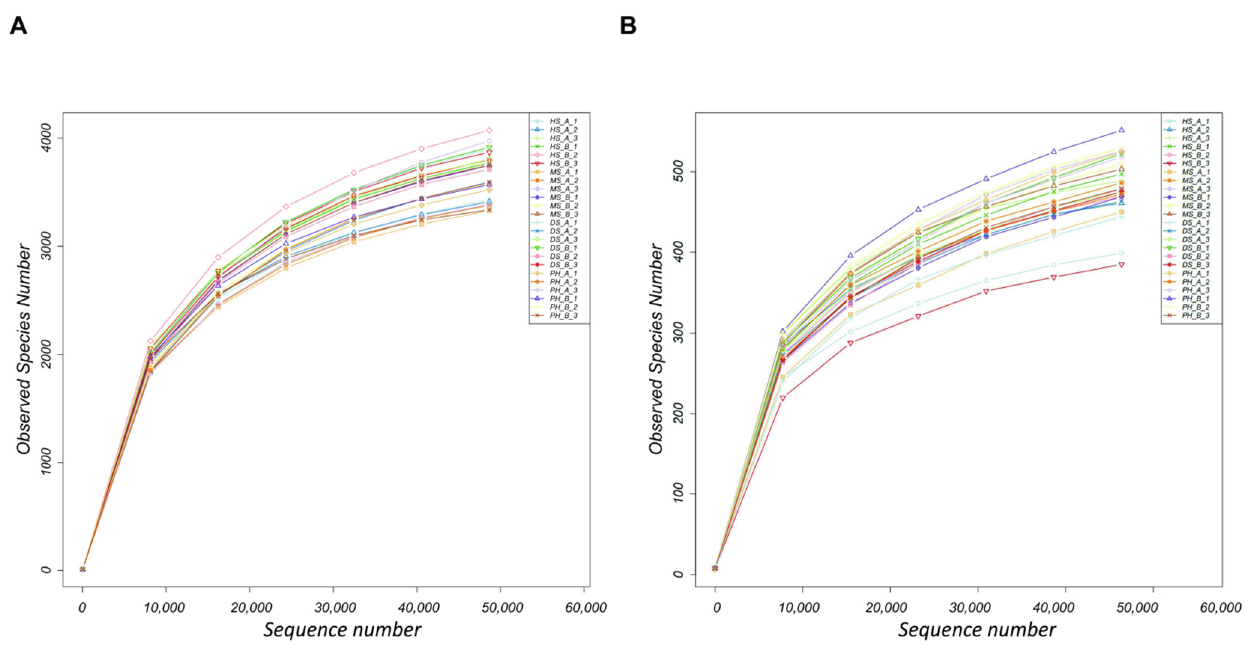
Figure 1. Rarefaction analysis. The rarefaction curve of the operational taxonomic units (OTUs) obtained from 16S rDNA ( A ) and ITS ( B ) amplicon sequencing in the rhizosphere of HGK60 and ZD958. The curves were named in the following form: “growth stage_cultivar_replicate”. HS—heading stage, MS—milk